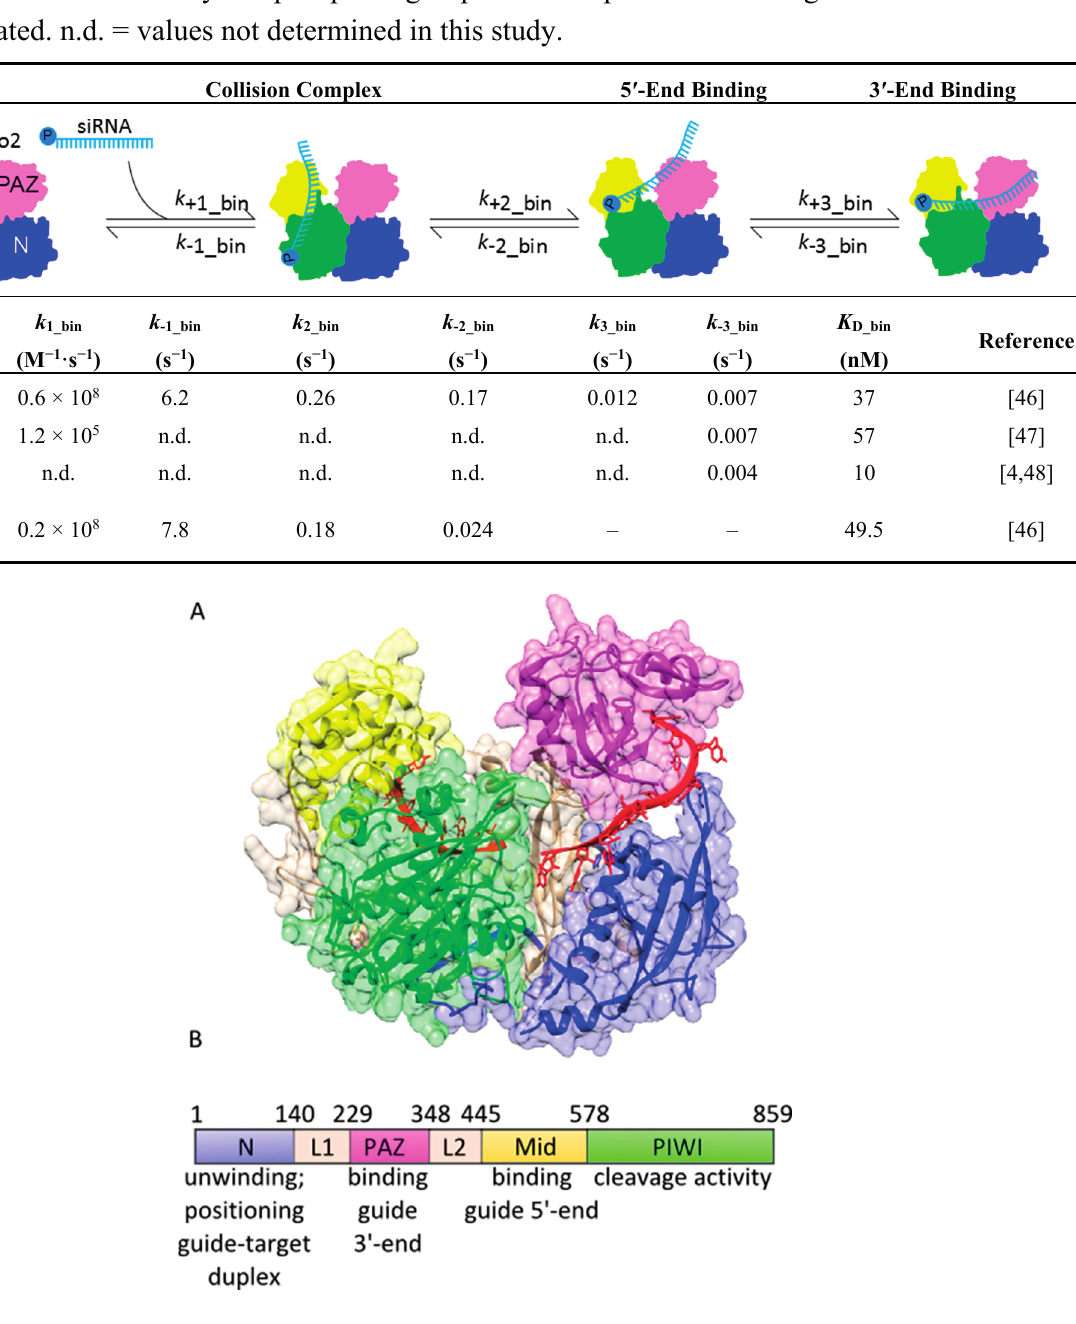
Figure 1. Domain organization of hAgo2. ( A ) X-ray structure of a binary hAgo2-guide complex (pdb: 4W5N) with the domains coloured individually. The guide strand is depicted in red; and ( B ) Schematic representation of the hAgo2 domains with their individual functions